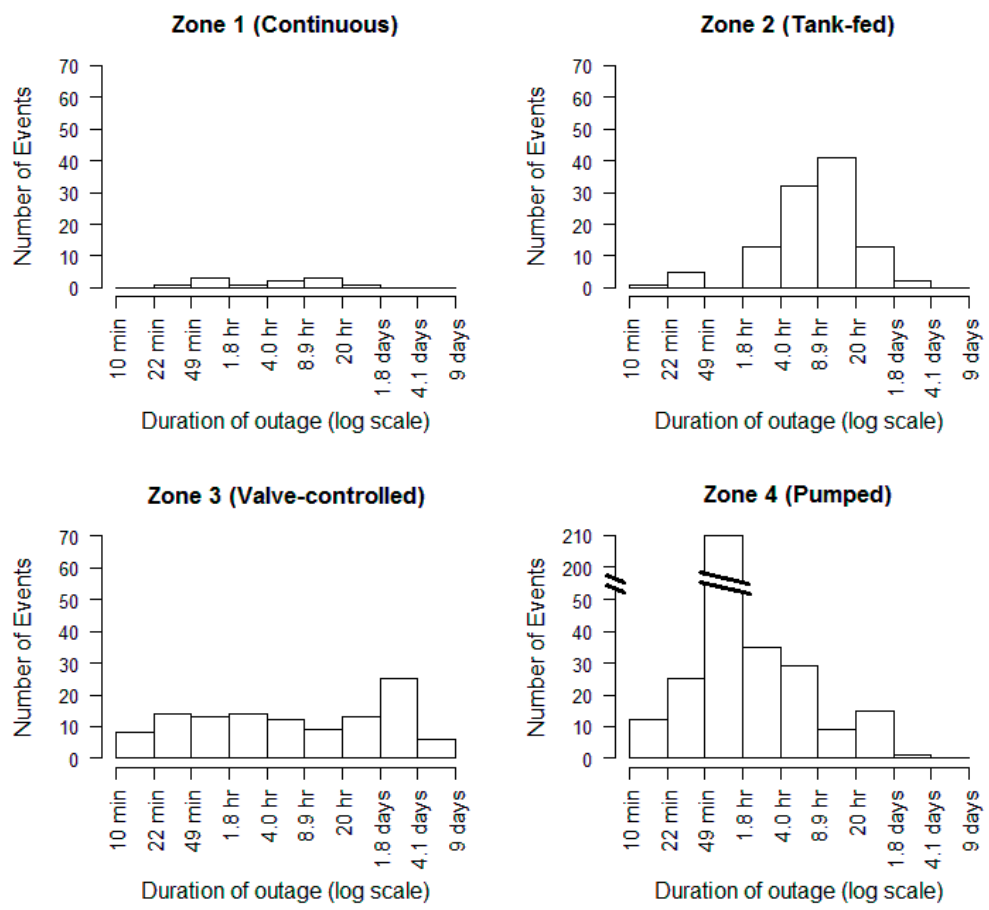
Figure 4. Distribution of outage durations for each study zone. Note that the x-axis is a log scale with nine evenly spaced bins between 10 min and 9 days; the y-axis for the Zone 4 graph is cut. According to the operation plan for the valve-controlled zone (Zone 3), outages there should have lasted 3 days. While the most common outage length was about three days (22% of outages were between 1.8 and 4.1 days long), many measured interruptions were much longer or shorter. Eight interruptions of > 4 days occurred. The three longest, lasting 6.3, 6.6, and 8.2 days, were associated with breaks in the single 4-inch pipe conveying water to Zone 3. Many shorter interruptions occurred when the Zone 3 pump station stopped temporarily during a supply period or the valve at the entrance was left partially open and supply at the downstream monitoring station fluctuated between o ff and on depending on demand elsewhere in Zone 3. (Operators sometimes left the valve at the entrance to Zone 3 partially open when it was scheduled to be closed so some flow entered Zone 3 and the rest went to a storage tank in an adjacent sector. This strategy was employed to supply the adjacent sector but avoid overflowing the storage tank there. During these times when the valve was partially open, the lower elevation portions of Zone 3 had supply and the higher portions did not, with the boundary between households with supply and without supply moving as demand fluctuated. Supply at the downstream monitoring station fluctuated between on and o ff during these times as the supply boundary moved back and forth across the monitoring